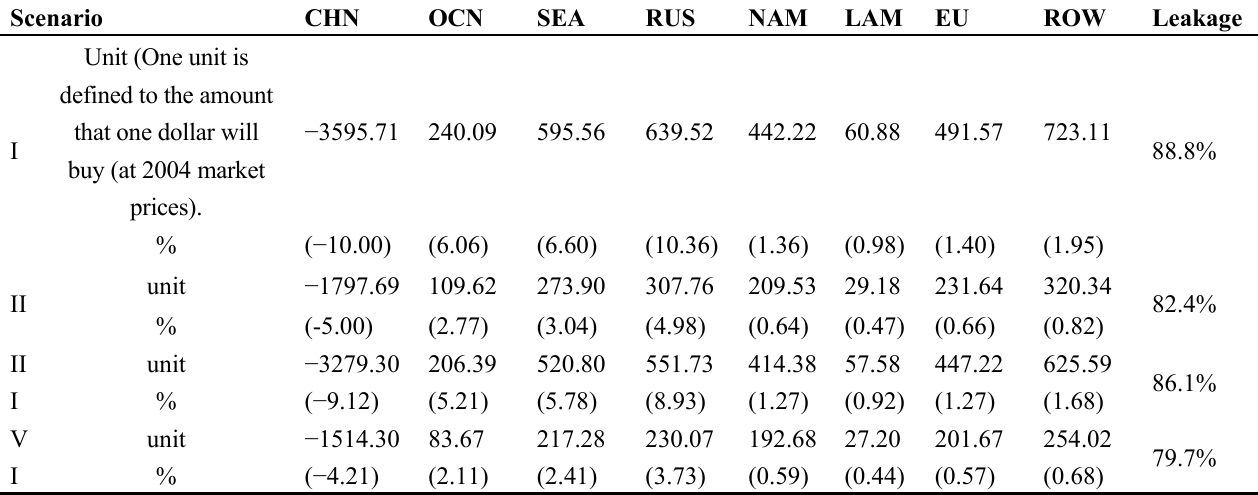
Table 6. Changes in timber production and